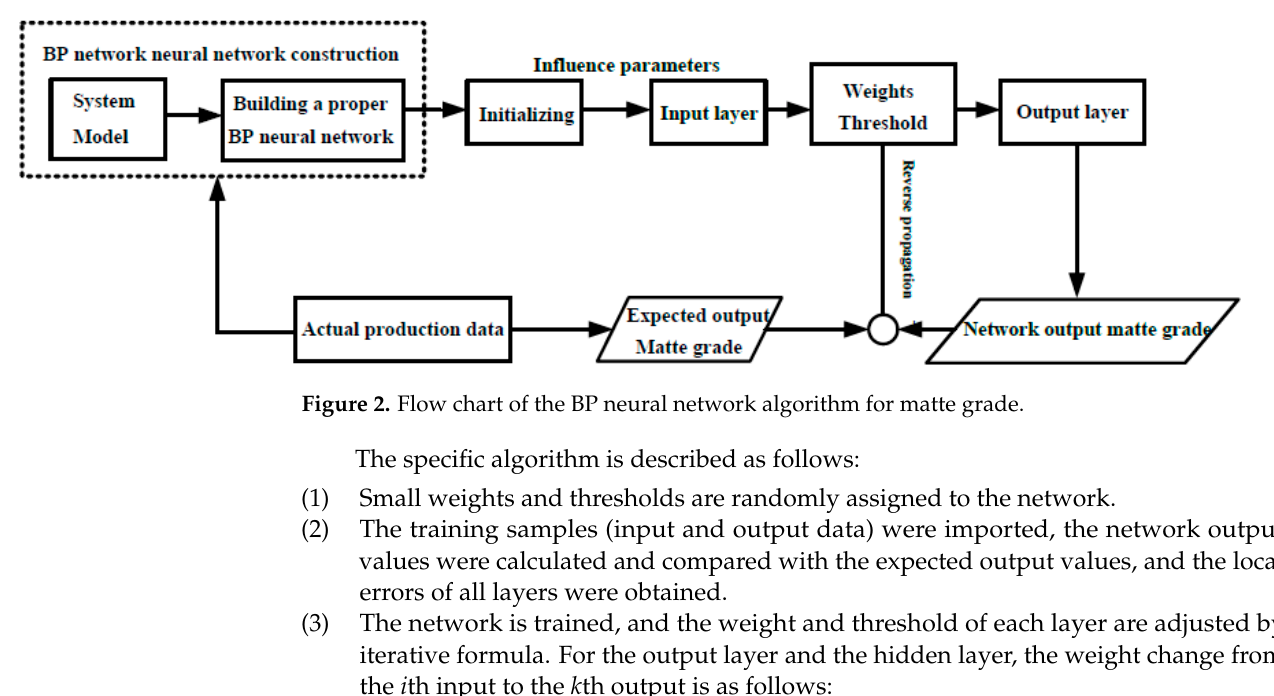
Figure 1. A schematic diagram of the BP neural network prediction model for matte grade.